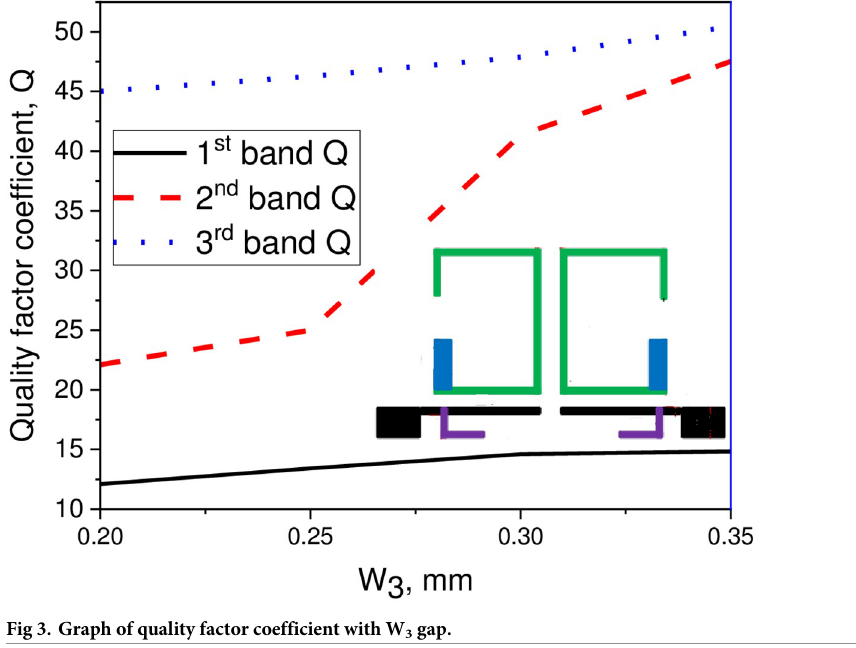
Fig 3. Graph of quality factor coefficient with W 3 gap.